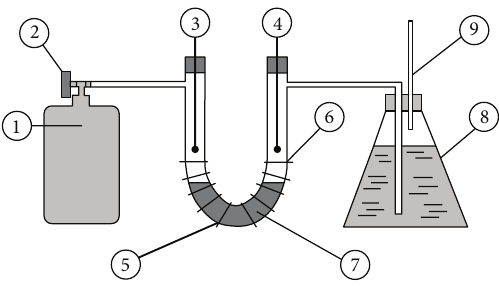
Figure 1: 1: volume containing propane/butane mixture; 2: valve to regulate flow of gas; 3, 4, 5: thermocouples; 6: heating wire; 7: U shape test glass with Sn :Bi alloy; 8: volume with water; 9: output tube.